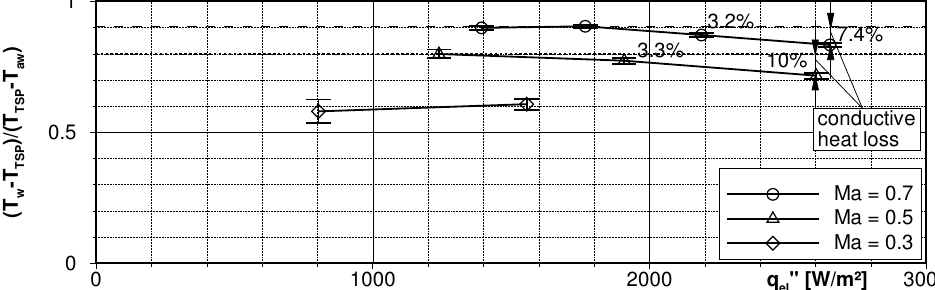
Figure 12. Integral quasi-HTC for all tested operating points including conductive loss